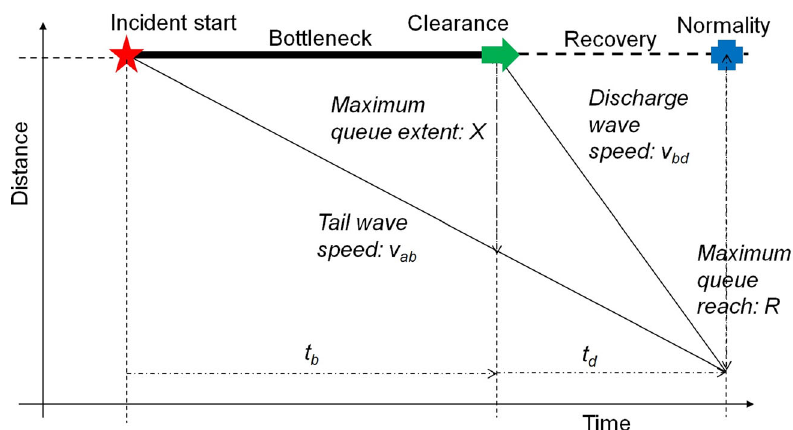
Fig. 4 Sketch of development and discharge of a simple queue showing